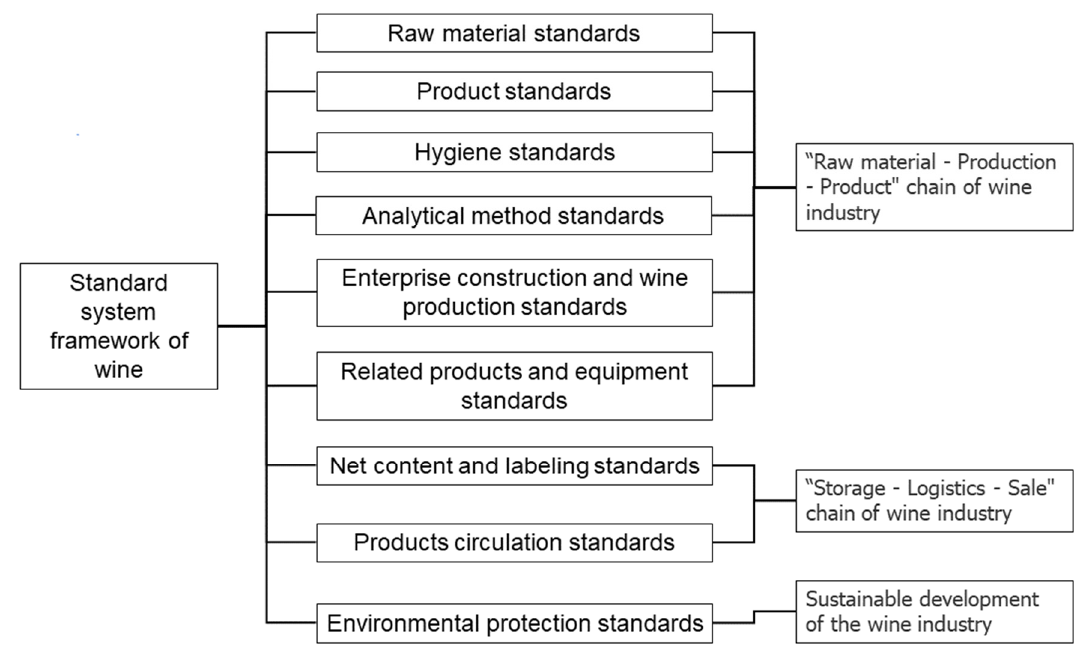
Figure 2. Standard system framework of wine in China.